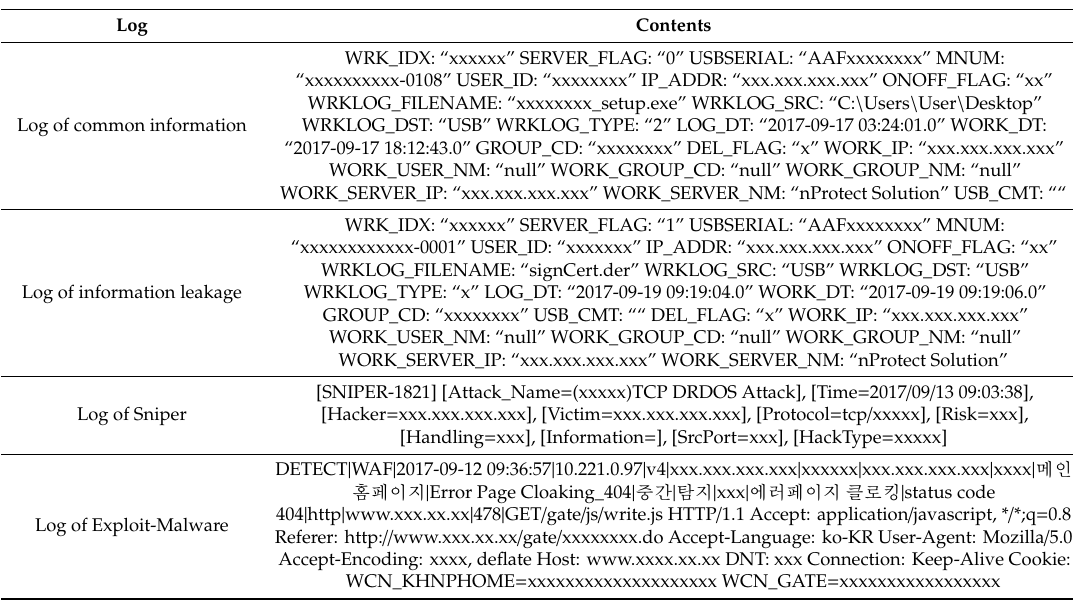
Table 2. Example of log dataset: in the log of ExploitMalware, some charaters is Korean, that means are “ 메 이 ᆫ ᄒ ᅩ ᆷ 페이지 ”: main site in the homepage, “ ᄌ ᅮ ᆼ ᄀ ᅡ ᆫ ”: middle, “ 탐 지 ”:detection and “ 에러페이지 클 로 킹 ”: cloaked error page.